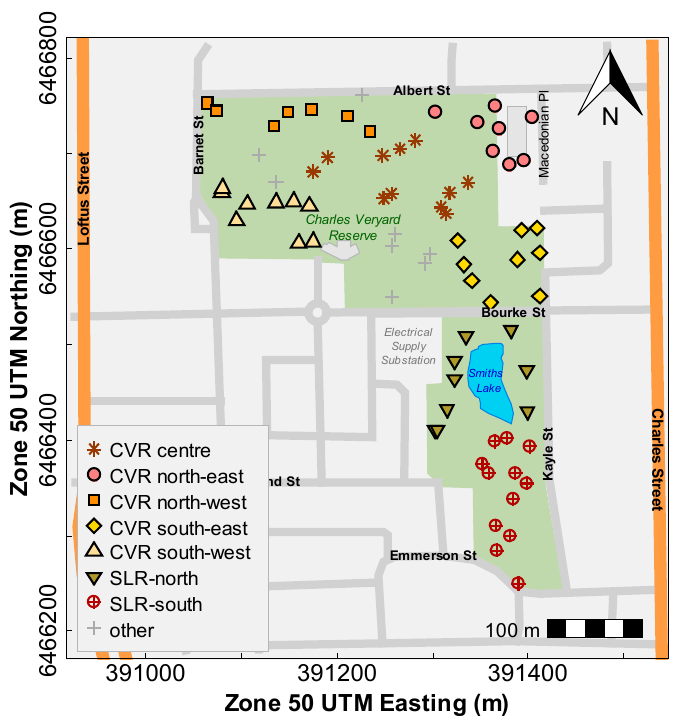
Figure 2. Simplified map showing sampling zones at Smith’s Lake and Charles Veryard Reserves. CVR is Charles Veryard Reserve; SLR is Smiths Lake Reserve.